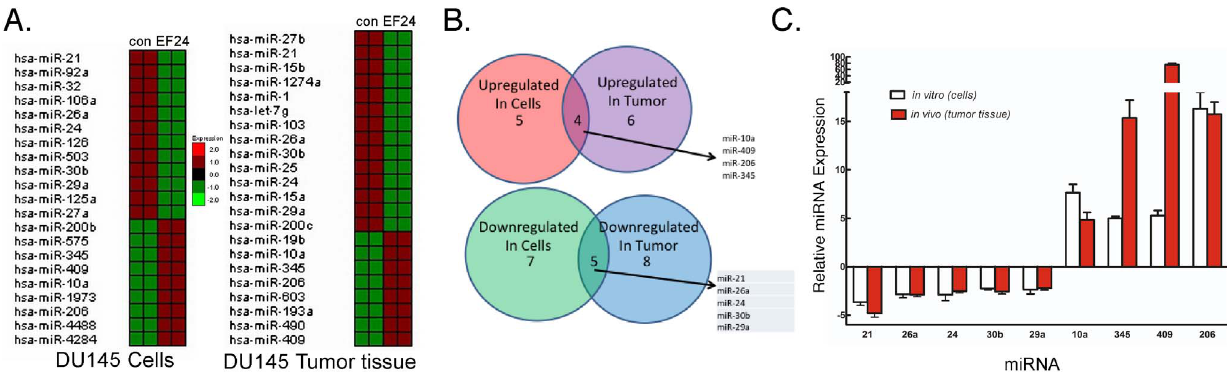
Figure 9. The effects of EF24 on miRNA expression invitro and invivo . (A) Total RNA was prepared from DU145 cells treated with vehicle and EF24 (5 m M, 24 hr), or tumor tissue from DU145 xenografts of control and EF24-treated mice (200 m g/kg body weight) at autopsy, and miRNA expression profiling was conducted on the nCounter Analysis System using the human V1 miRNA assay kit. (B) Venn diagram analysis of the genes upregulated or downregulated by EF24 treatment in cells and tumor tissue. (C) PCR validation of the genes upregulated or downregulated by EF24 treatment in both cells and tumor tissue (n=3), and expressed as relative gene expression (EF24-treated/control). melanoma and prostate cancer, which may be mediated in part by targeting a miR-21 anti-apoptotic pathway.